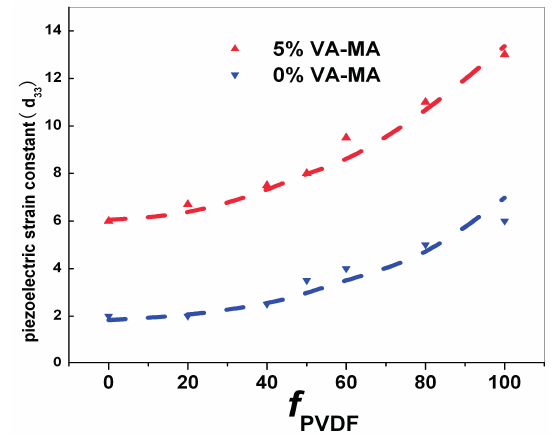
of PA11/PVDF blends. 33